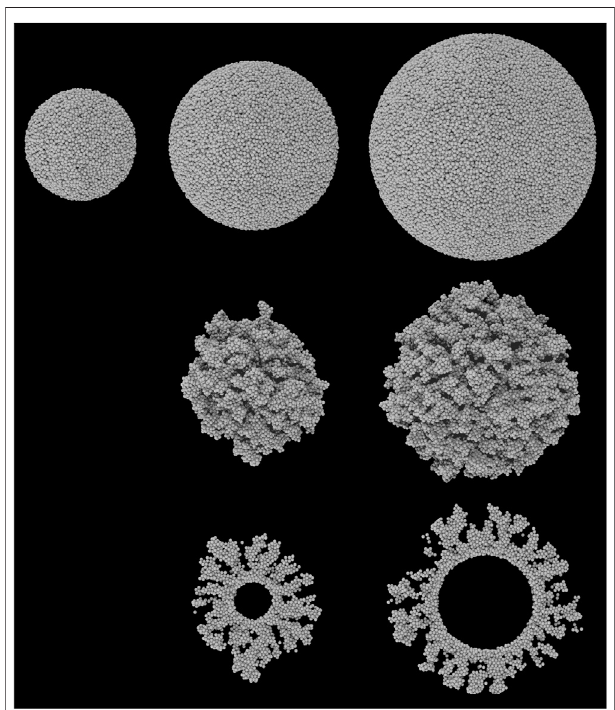
FIGURE 1 | Ray-traced images of the fi ve grain types used in the chemical models. All grains are composed of a collection of spheres representing carbon atoms. Top row: the three non-porous grains; middle row: the two porous grains, of comparable size to the two largest non- porousgrains; bottom row: thecross sections ofthe twoporous grains. From left to right, grains have a radius approximately 50, 75, and 100 Å. Note that the inner portions of the grains are removed to simplify the chemical kinetics calculations; the inner void is completely inaccessible to surface atoms and